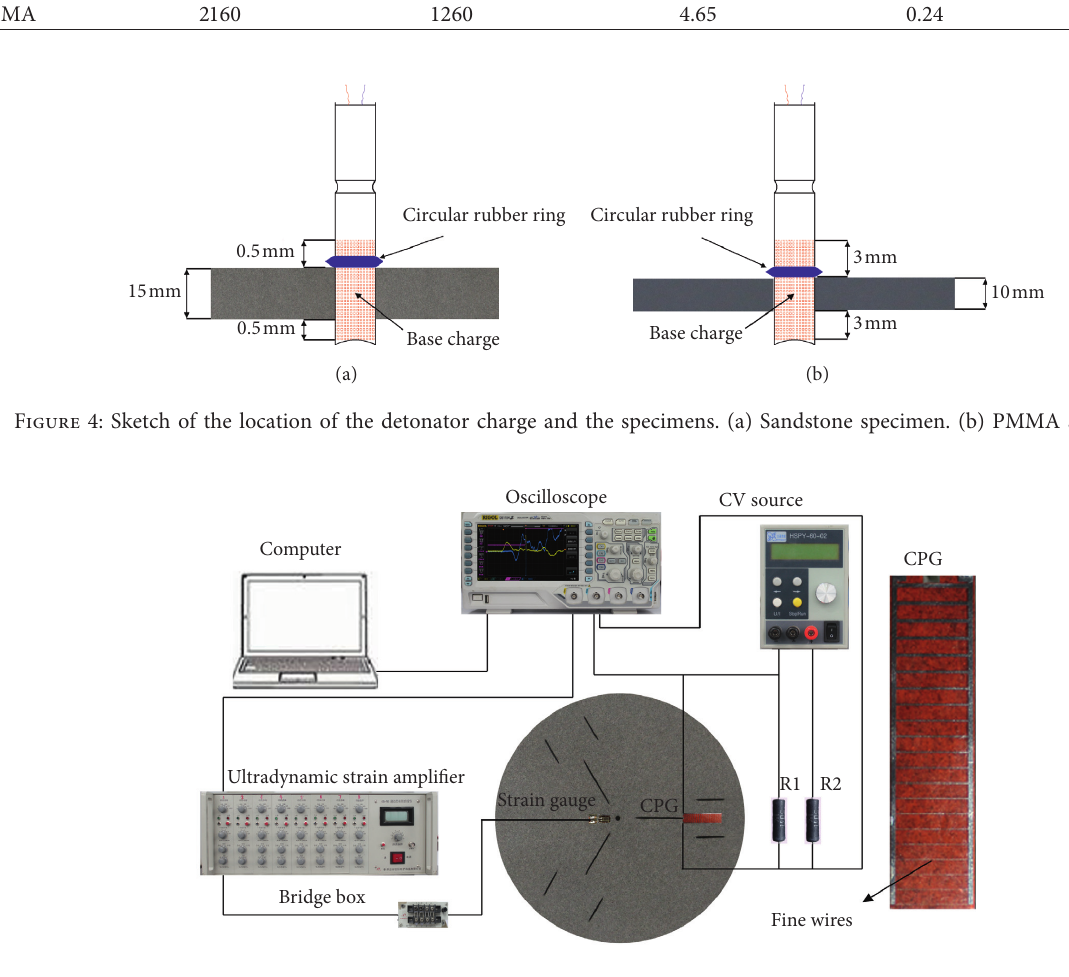
Figure 5: The measuring system applied in the blasting